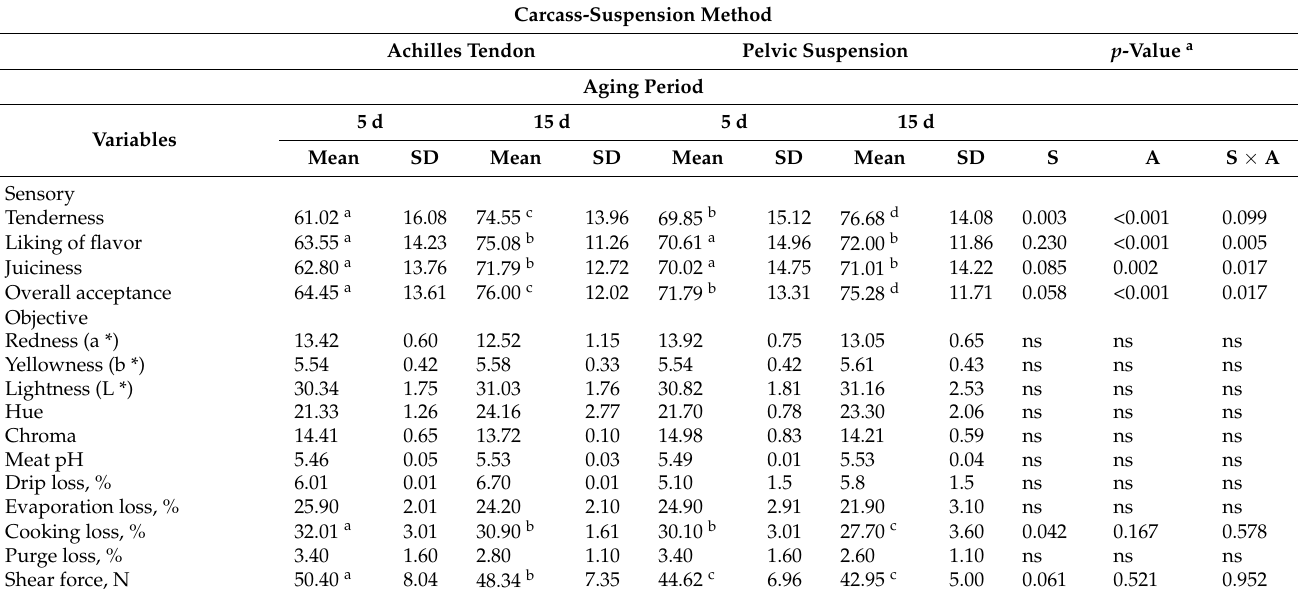
Table 2. Sensory and objective meat quality traits of aged samples (5 or 15 days) from feedlot-finished Nellore bulls whose half-carcasses were suspended by the traditional Achilles tendon method ( n = 20) or by the pelvic bone ( n = 20).